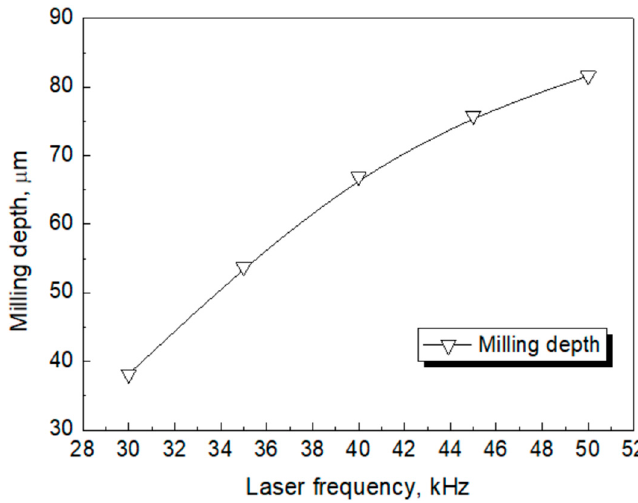
Figure 7. Milling depth after laser milling at different pulse repetition rates.